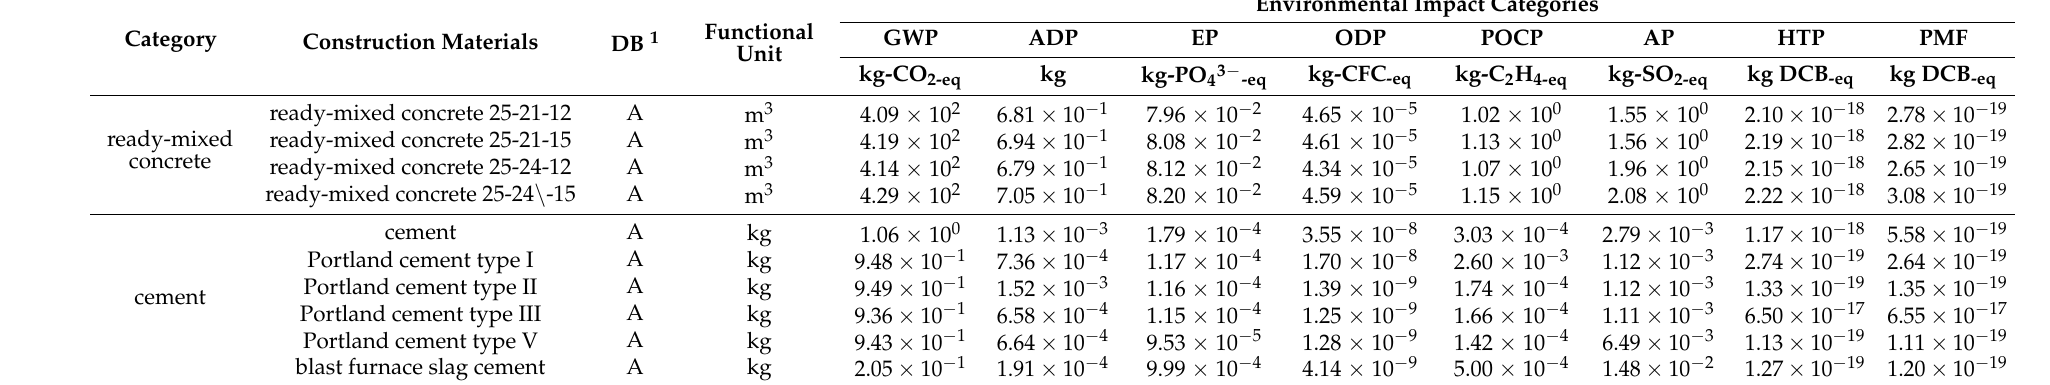
Table 4. Environmental impact coefficients of construction materials